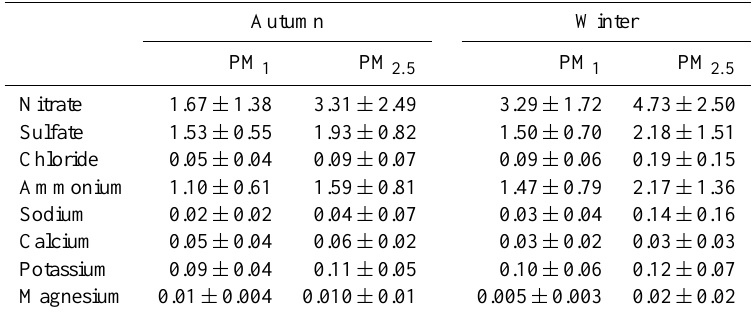
Table 3. Comparison of inorganic composition of the daily PM 1 and PM 2 . 5 high volume sampler filters for autumn and winter (mean ± 1 σ standard deviation in µgm − 3 )